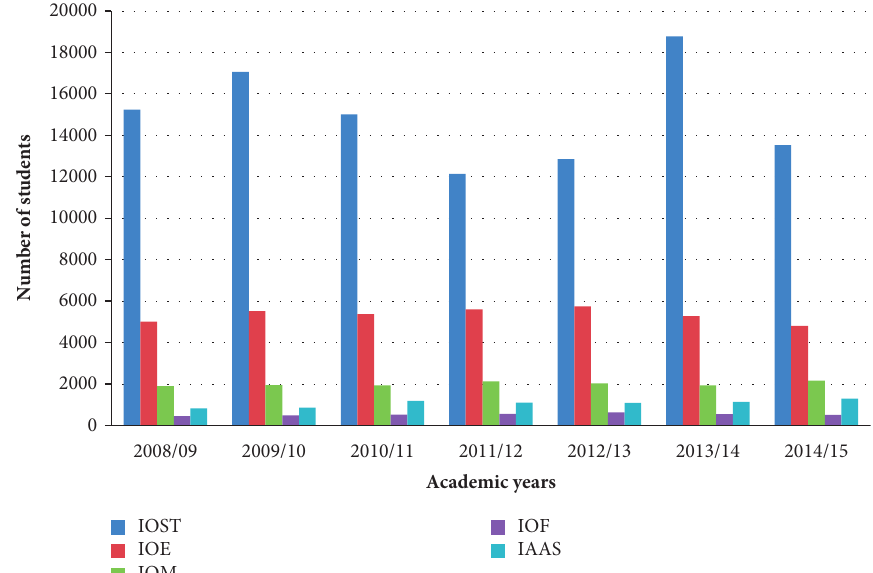
Figure 1: Enrollment trend at five institutes of TU.